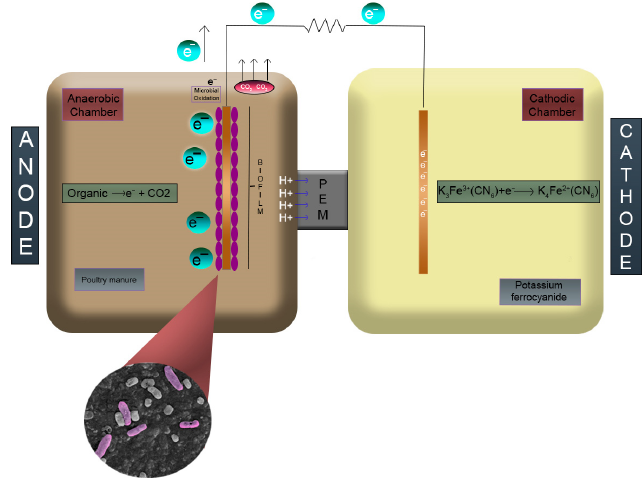
Figure 1. Microbial Fuel Cells (MFC) batch